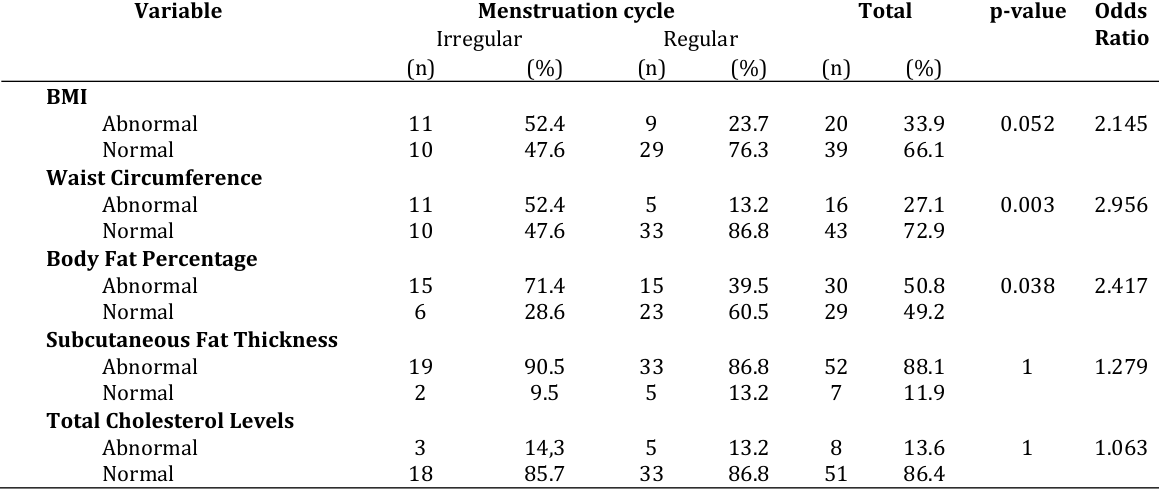
Table 2. The result of Bivariate Analysis Using Chi-Square (n= 59) Variable